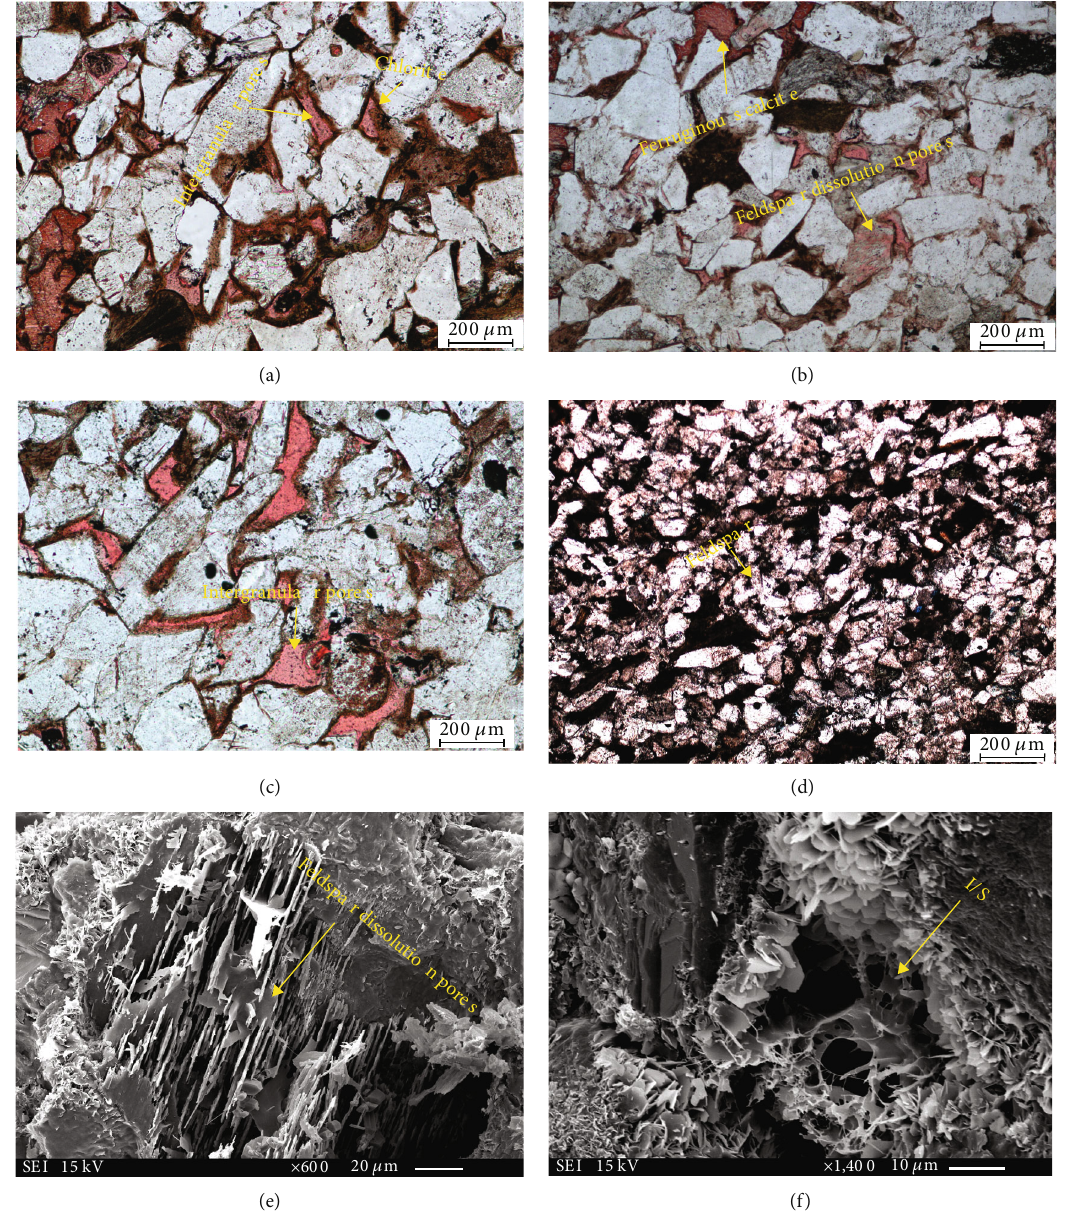
Figure 2: Typical photos of C 6 and C 7 formations. (a) Intergranular pore, chlorite, well X 28, C 6. (b) Intergranular pore, ferrocalcite, well X 39, C 6. (c) Chlorite, intergranular pore, well X 13, C 6. (d) Very fi ne-grained arkose, well D 6266, C 7. (e) Feldspar dissolution, well D 1978, C 7. (f) Yimeng mixed layer, well D 6547, C